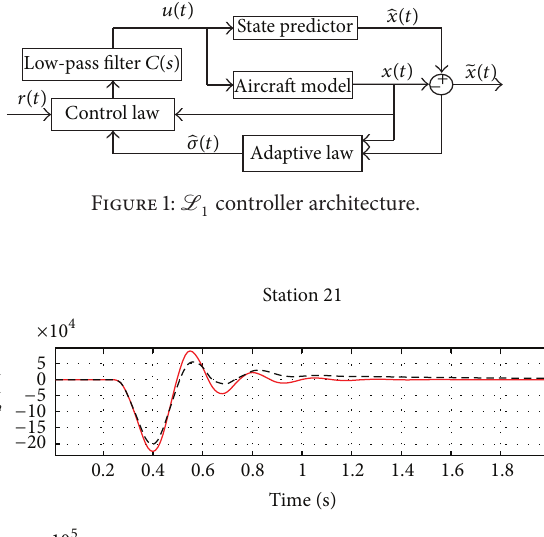
Figure 3: Rigid variable variation for nominal case (Case A, Table 3). Red solid line: open loop. Black dotted line: closed loop.